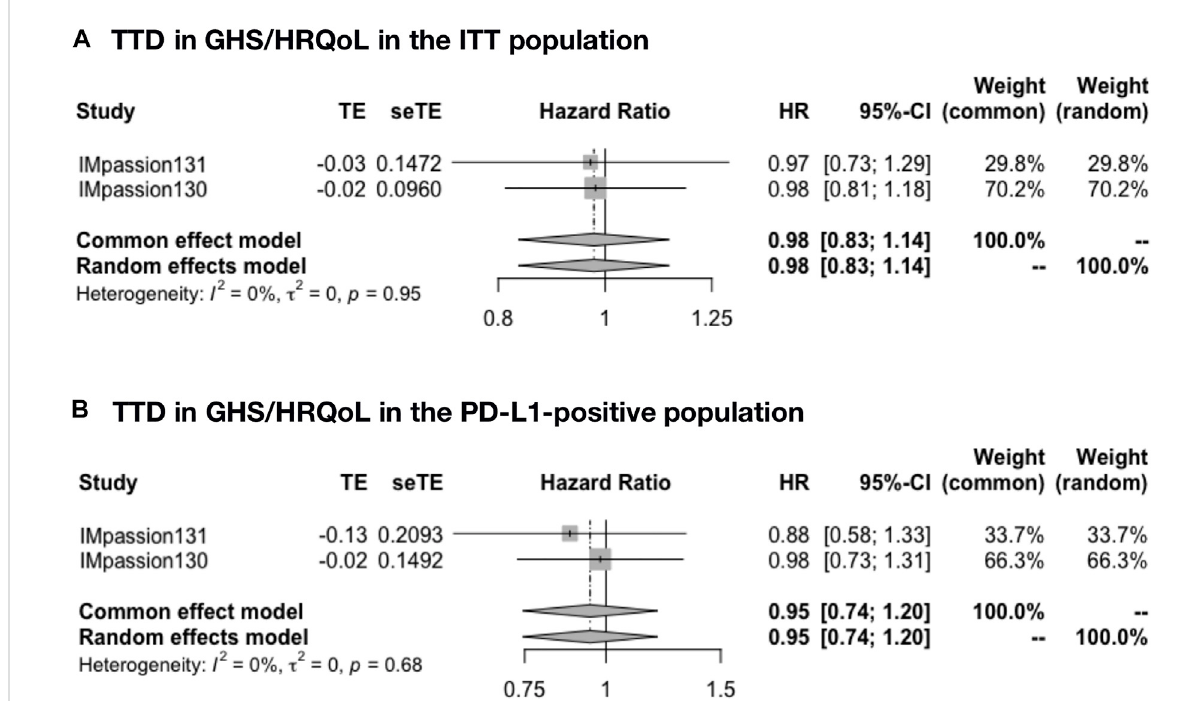
FIGURE 4 Pooled TTD in adjuvant therapy clinical trials. (A) TTD in GHS/HRQoL pooled results in the ITT population in the comparison of ICIs plus CT versus placebo plus CT adjuvant therapy. (B) TTD in GHS/HRQoL pooled results in the PD-L1-positive population in the comparison of ICIs plus CT versus placebo plus CT adjuvant therapy. TTD, time to deterioration (de fi ned as a 10-point decrease); GHS/HRQoL, global health status/health- related quality of life; ITT, intent-to-treat; HR, hazard ratio; 95% CI, 95% con fi dence interval; ICIs, immune checkpoint inhibitors; CT,